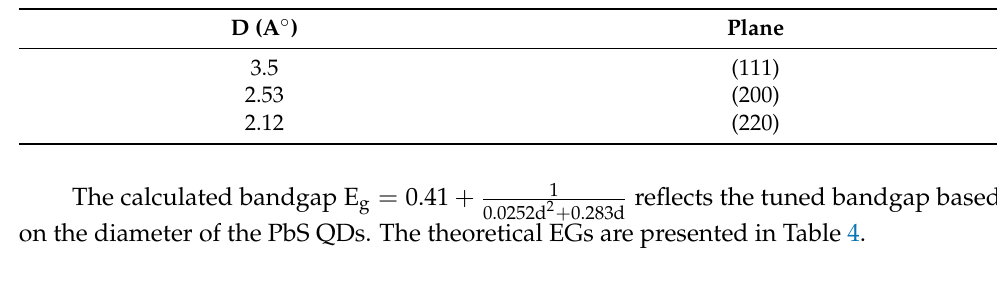
Table 4. Theoretical bandgaps based on the size of the